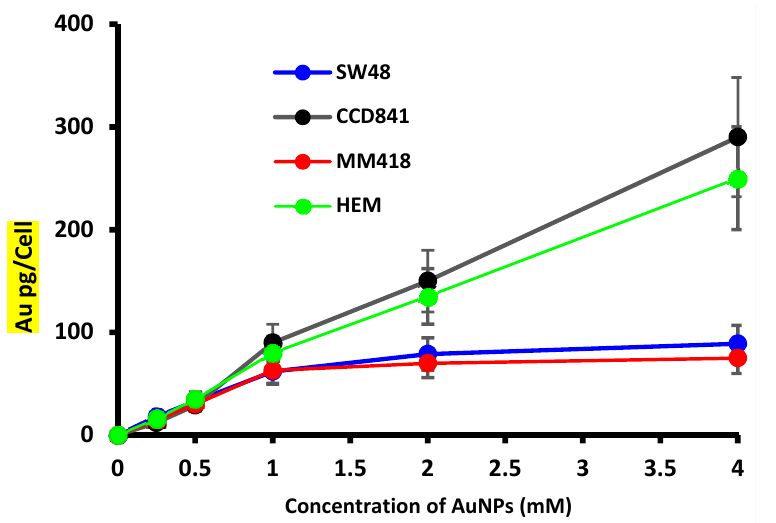
Figure 1. Effect of external AuNPs concentration on the accumulation of gold in human colon adenocarcinoma (SW48) and melanoma (MM418-C1) cell lines compared to their non-cancerous counterparts (CCD841 and HEM cells). The cells were exposed to 0–4 mM AuNPs for 24 h, and the level of Au in the cells were determined using inductively coupled plasma mass spectrometry (ICP MS). The ICP MS intensities were converted to mass of AuNPs per cell by using Au ion standard curve and cell counts. Results are expressed as the mean ± SEM of 3 replicates.